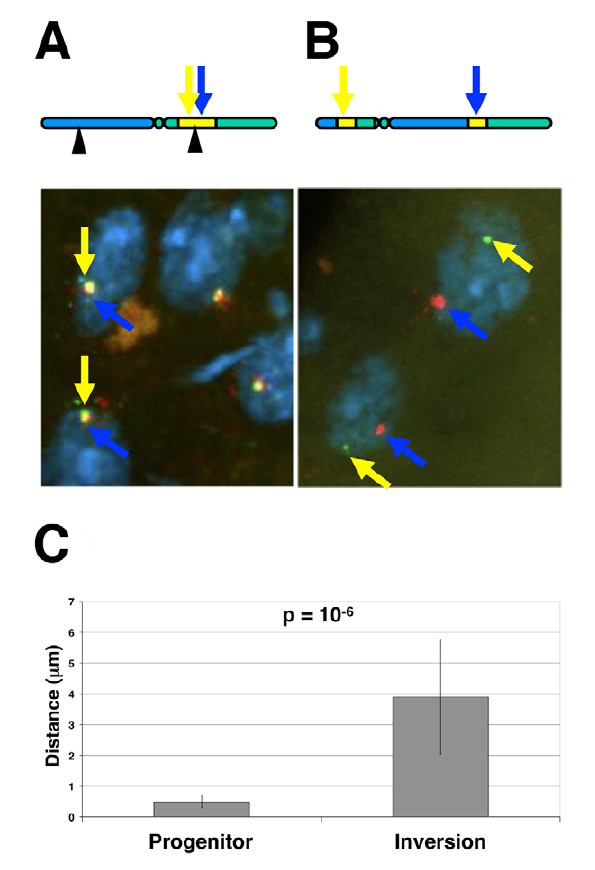
Figure 5. Two colour DNA FISH in spermatocytes . Confocal microscopy and 3D measurement of separation distances between proximal and distal probes. DNA FISH 3D reconstructed image from confocal stack on spermatocytes of (A) progenitor stock and (B) inverted stock. Proximal probe (A555, yellow arrow), distal probe (A488, blue arrow). Nuclei are counterstained with DAPI. (C) Histogram plot of separation distances between proximal and distal probes in progenitor ( n =29) and inversion ( n